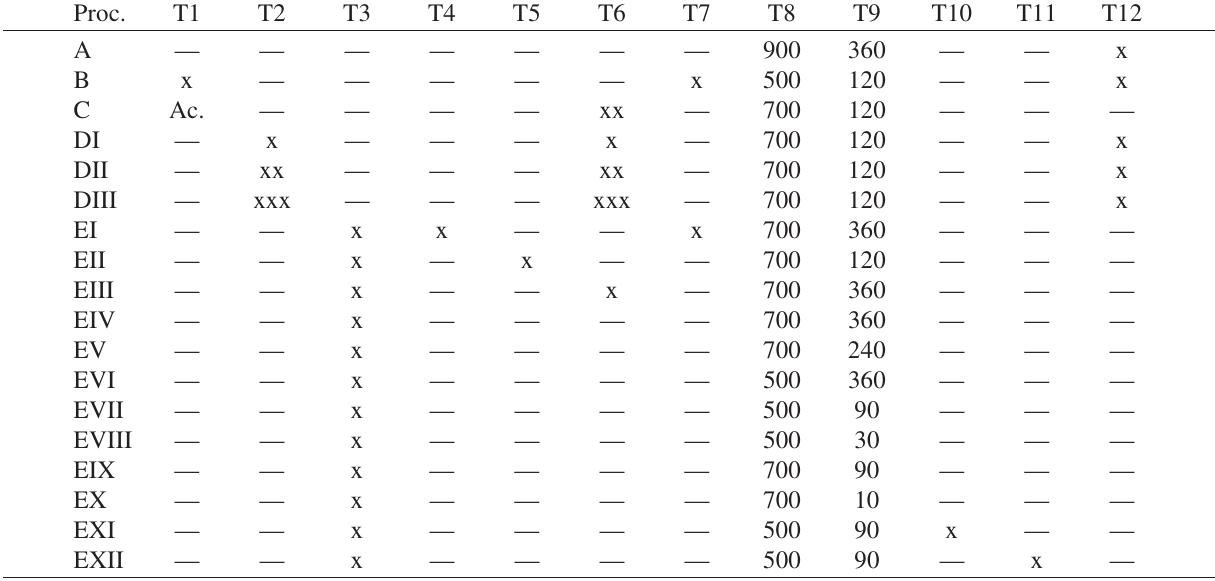
Table 1. Chemical and physical preparation steps to extract silica from rice hulls (S. Borja, RGS, Brazil, cultivator IRGA 409-407) through processes A to EIII. Proc.